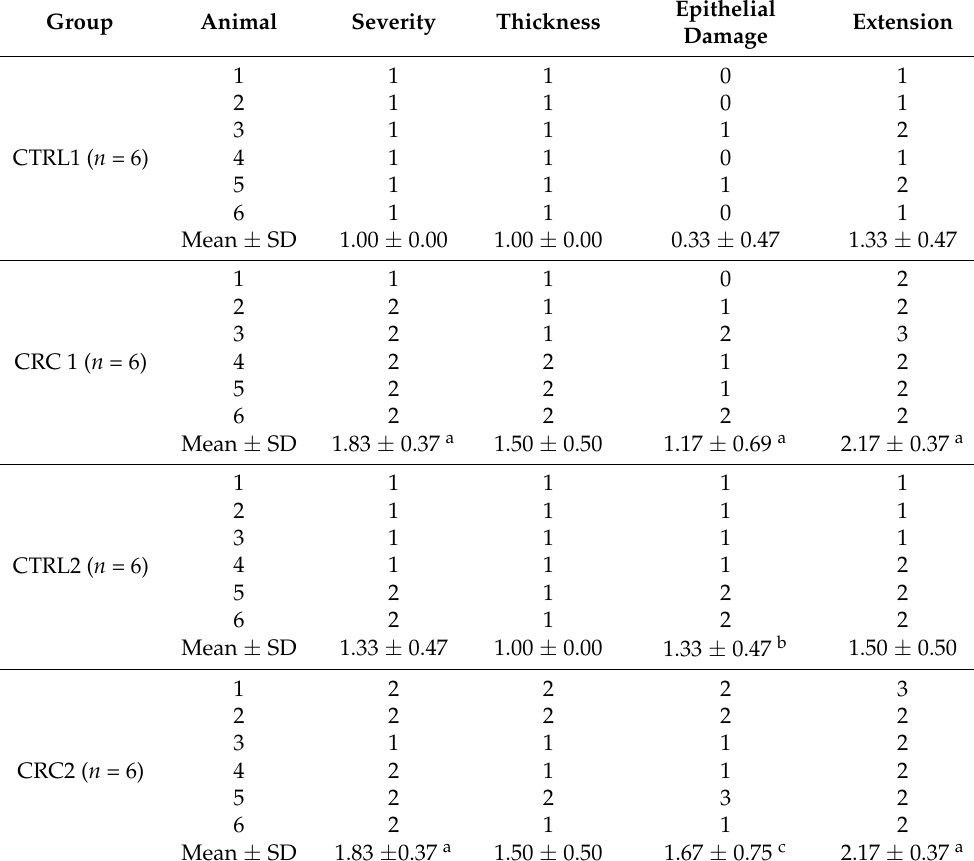
Table 6. Degree of inflammation of rats’ colon. Data are presented as mean ± SD. Group